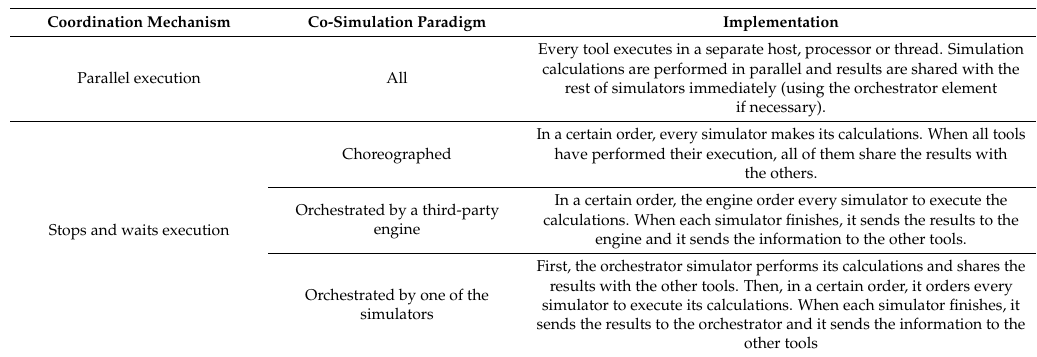
Table 8. Coordination